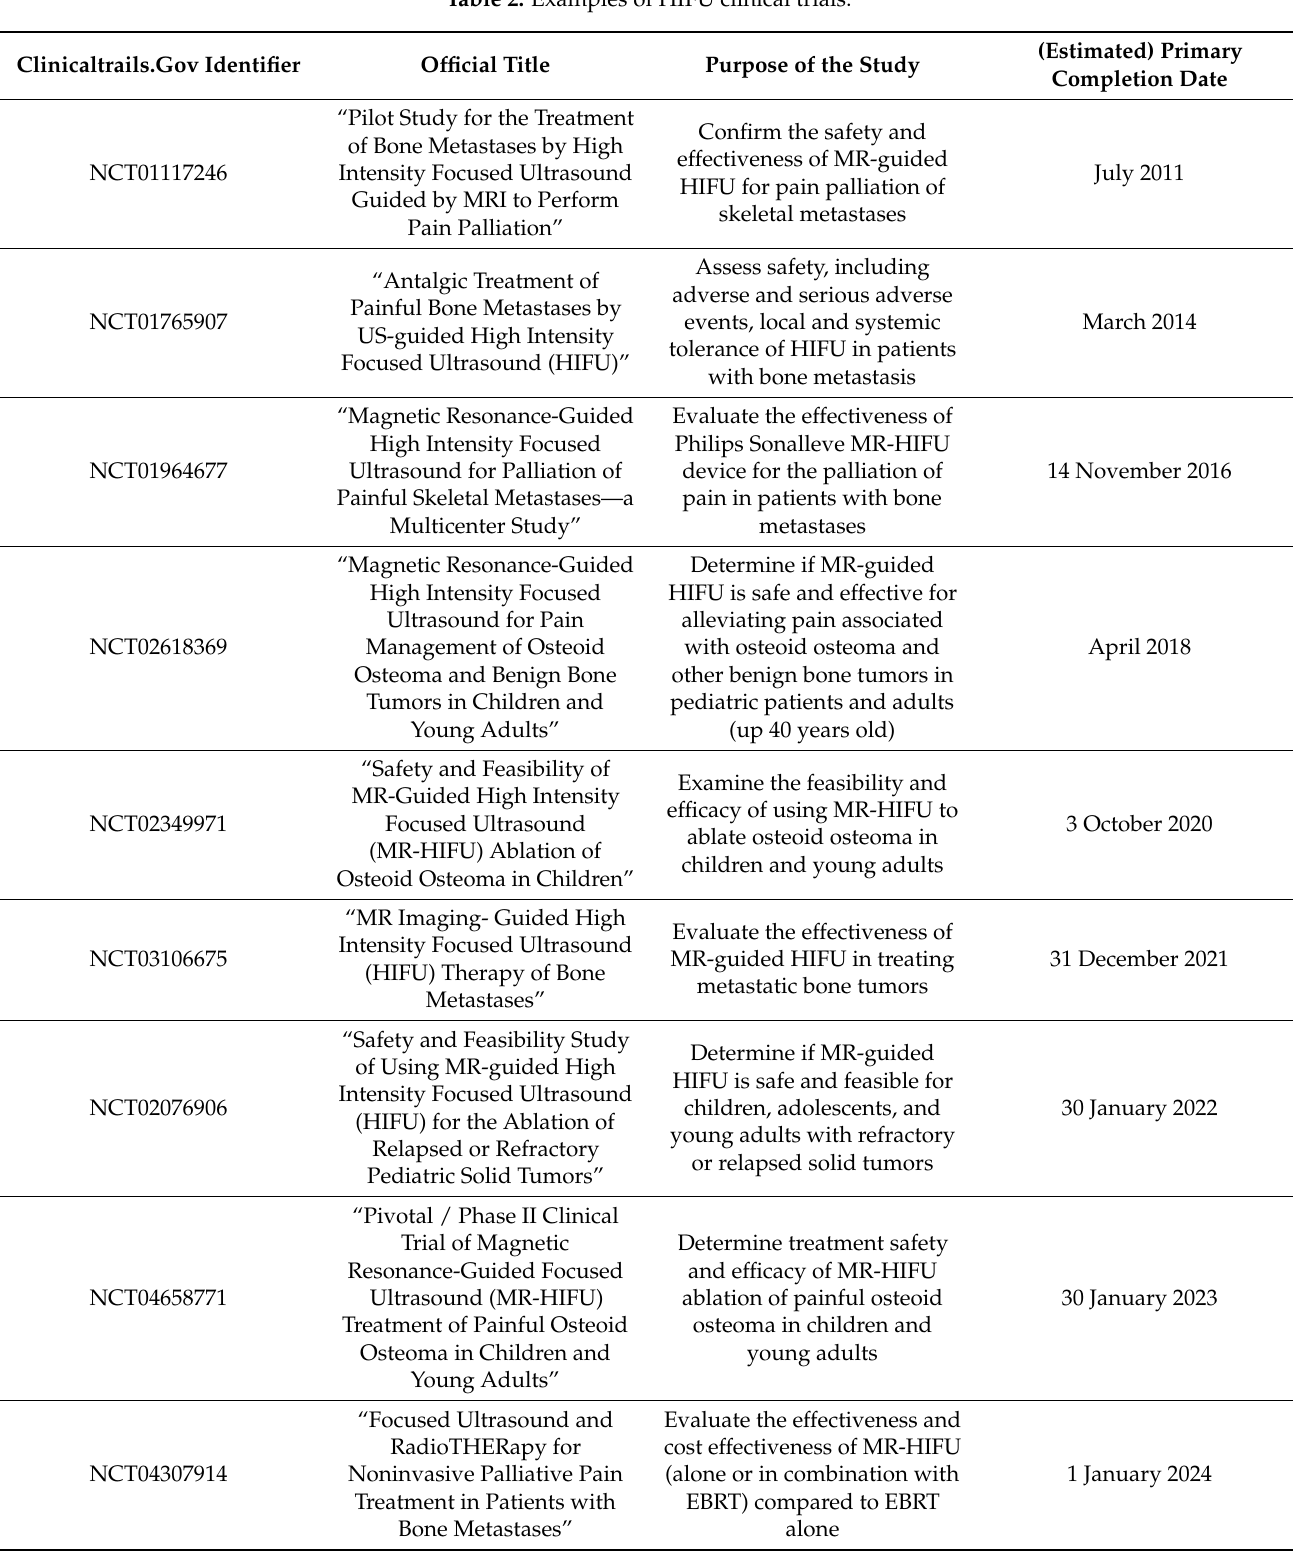
Table 2. Examples of HIFU clinical